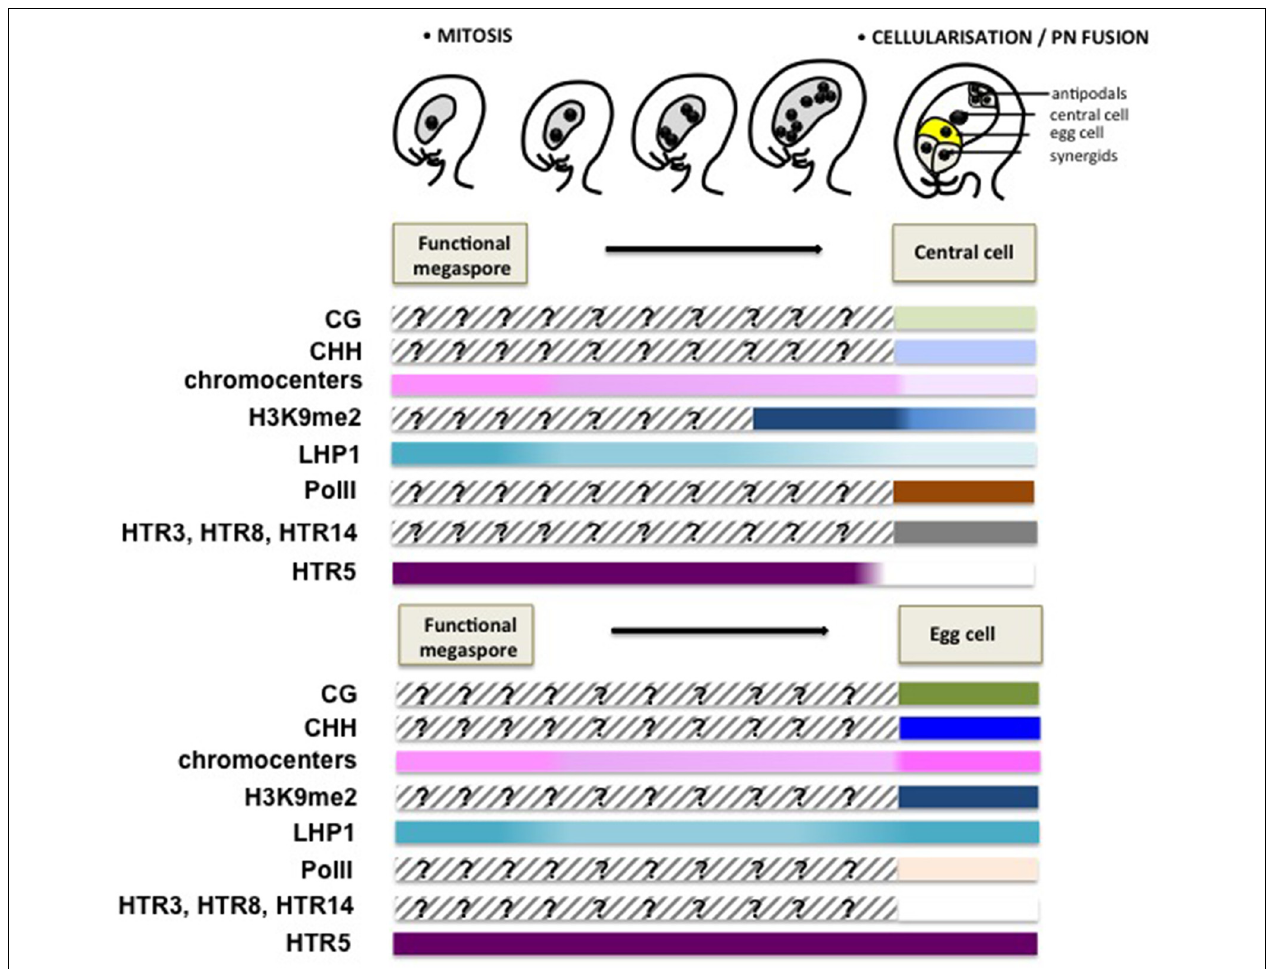
FIGURE 4 | Chromatin dynamics during female gametogenesis. This scheme summarizes mostly cytogenetic and GFP reporter protein analyses suggesting large-scale chromatin dynamics events during female gametophyte development. Although genome-wide, molecular profiling of the chromatin state is currently missing, these data provide, like for Figure 3 , a conceptual framework for apprehending the extent and potential significance of chromatin dynamics during this developmental stage. Following cellularization, a dimorphic chromatin landscapes are established between the egg cell and the central cell.The central cell chromatin harbors a decondensed chromatin with a low heterochromatin content, correlating with low levels of H3K9me2 and the H3K27me3 reader protein LHP1, but is enriched in active PolII (Ser2 phosphorylated PolII) allowing for active transcription (Pillot etal., 2010).The notable absence of DNA